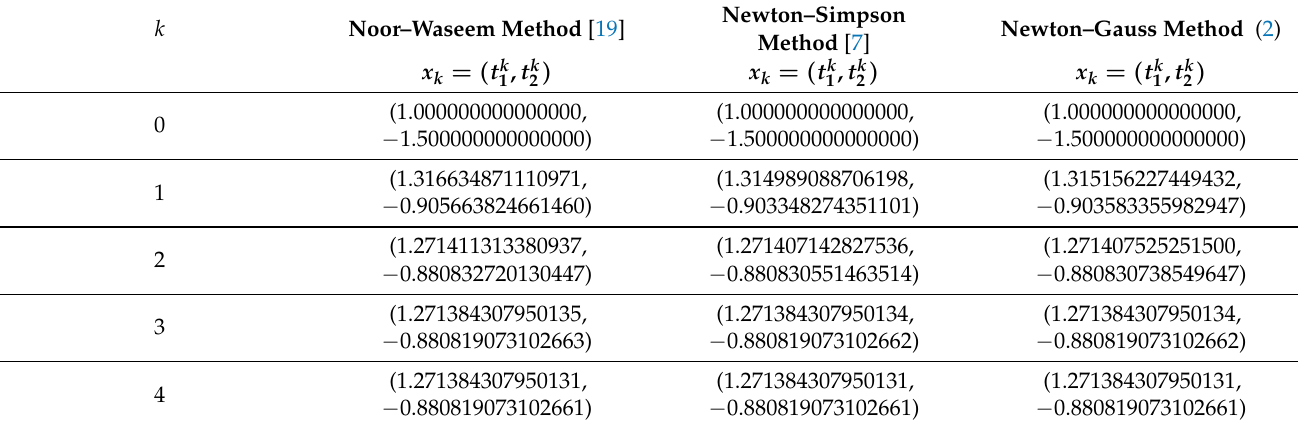
Table 4. Method—Order 3.